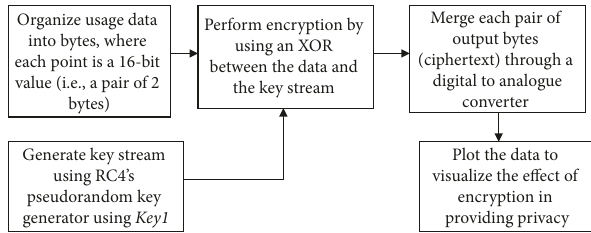
Figure 4: Applying RC4 to electrical usage data.